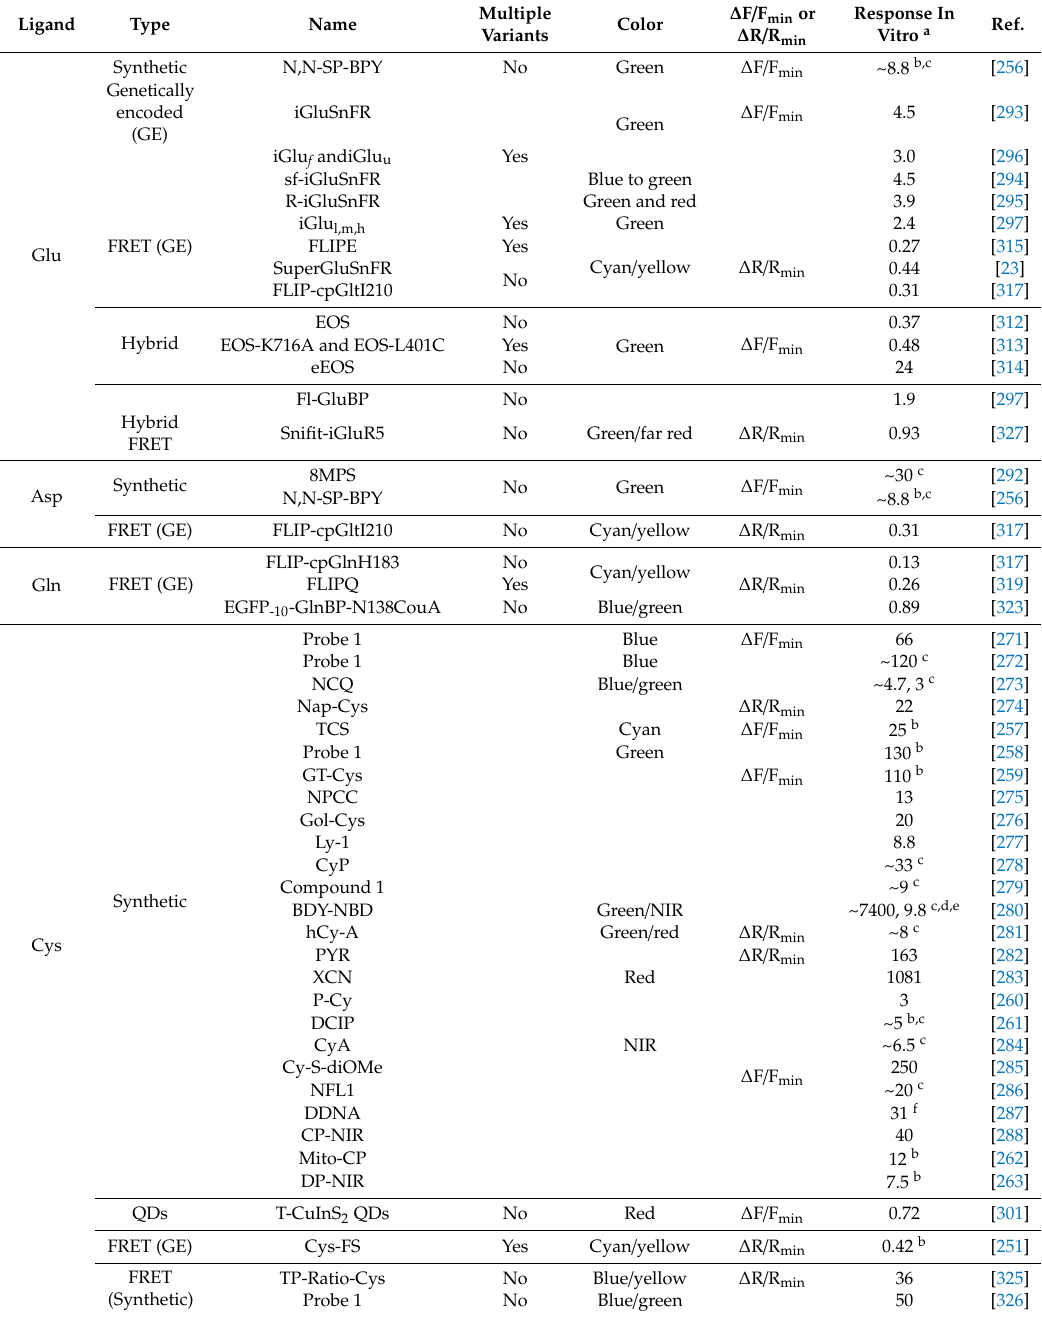
Table 2. Fluorescent indicators for amino